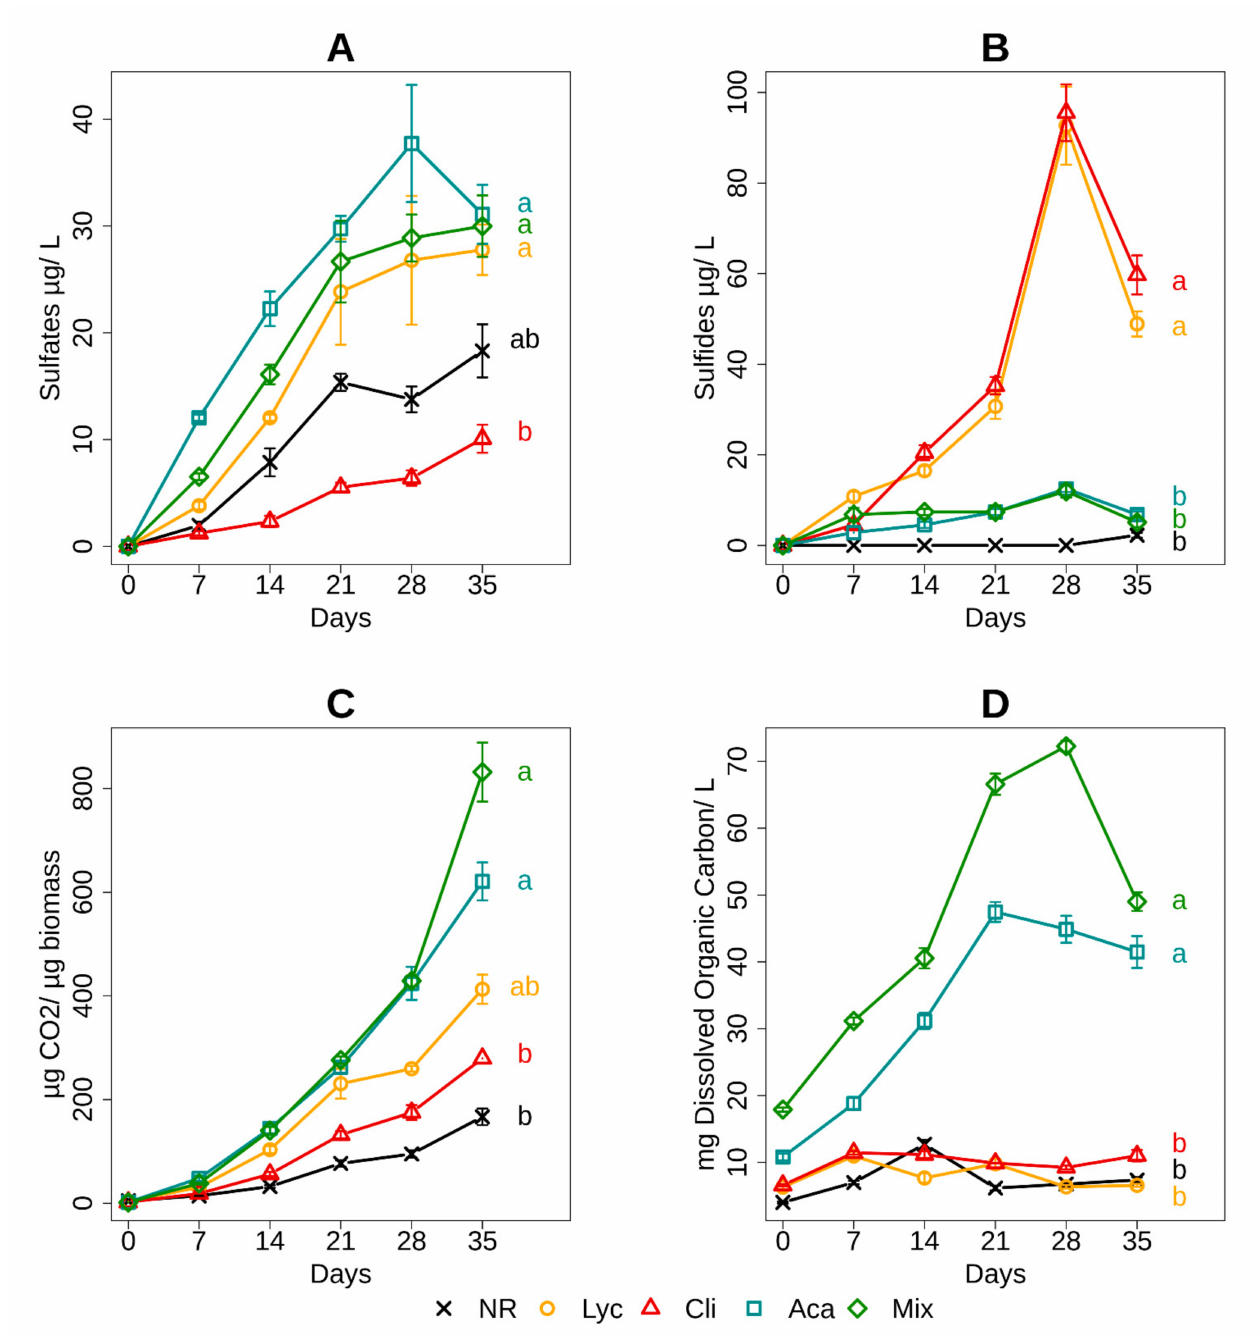
Figure 3. Sulfates ( A ) and sulfides ( B ) concentrations, microbial respiration ( C ) and dissolved organic carbon ( D ) during 35 days of anaerobic incubation in the five sites ( n = 5, mean ± SD). For each site and at the end of each curve, an indicator letter has been added. Different letters (a,b,c,d) between sites indicate significant differences with p < 0.05 in the evolution of the measured parameter over time, obtained by repeated-measures ANOVA at the 5% critical